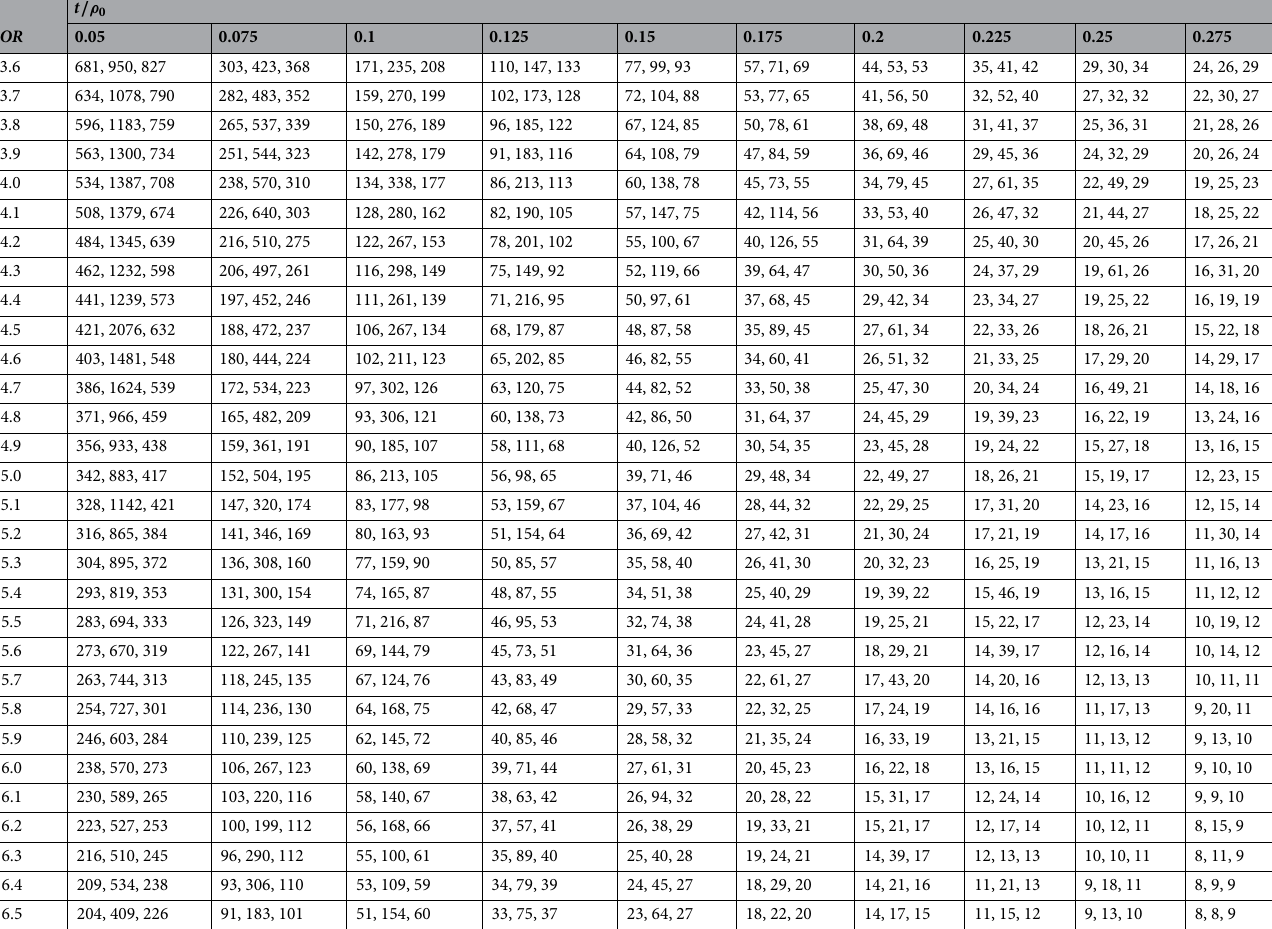
Table 2. Optimum DSP − ( n 1 , n 2 ) for life tests based on Pareto type IV distribution having shape parameters (cid:31) = 2 and η = 0.5 ( r = 0.90). Key: n 1 , n 2 , ASN at p 1